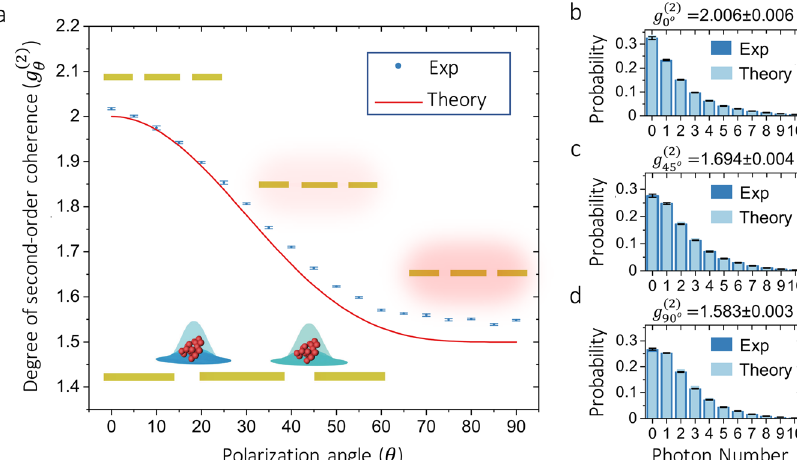
Fig. 4 Modi fi cation of the quantum statistics of a multiphoton system comprising two sources. The modi fi cation of the quantum statistics of a multimode plasmonic system composed of two independent multiphoton sources is shown in panel ( a ). Here, we plot experimental data together with our theoretical prediction for the degree of second-order coherence. The theoretical model is based on the photon-number distribution predicted by Eq. (2) for two independent multiphoton systems with thermal statistics and same mean photon numbers satisfying (cid:1) n s ¼ (cid:1) n Pl. As demonstrated in ( b ), the photon- number distribution is thermal for the scattered multiphoton system in the absence of near fi elds ( θ = 0 ∘ ). However, an anti-thermalization effect takes place as the strength of the plasmonic near fi elds is increased ( θ = 45 ∘ ), this is indicated by the probability distribution in ( c ). Remarkably, as reported in ( d ), the degree of second-order coherence of the hybrid photonic – plasmonic system is 1.5 when plasmonic near fi elds are strongly con fi ned ( θ = 90 ∘ ). These results unveil the possibility of using plasmonic near fi elds to manipulate coherence and the quantum statistics of multiparticle systems. The error bars represent the standard deviation of ten realizations of the experiment. Each experiment consists of ~100,000 photon-number-resolving